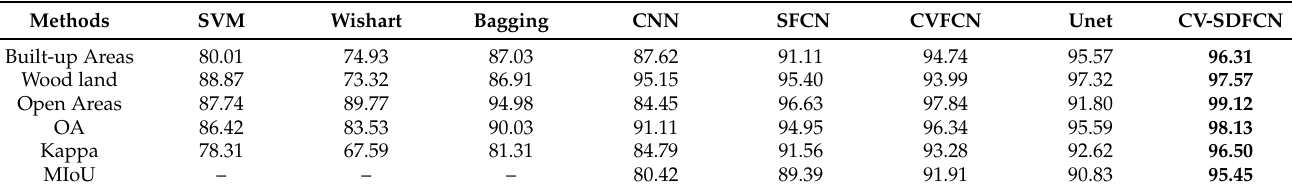
Table 2. Classification accuracy of the Oberpfaffenhofen dataset ( % ) .